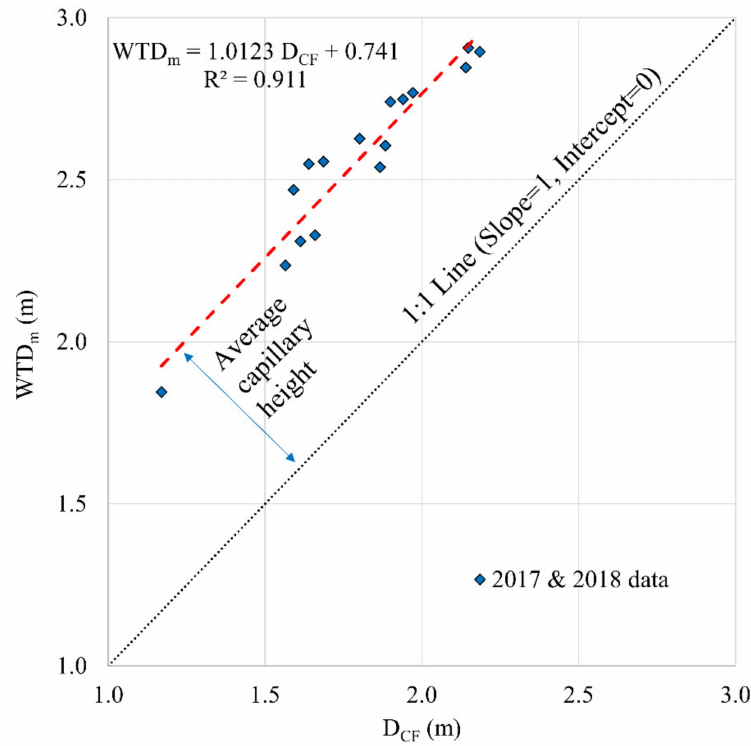
Figure 9. Comparison of the measured water table depth (WTD m ) and the estimated depth to the capillary fringe (D CF ) based on ground penetrating radar (GPR) data for all 16 GPR surveys. 1:1 line indicates the measured and GPR-based water table